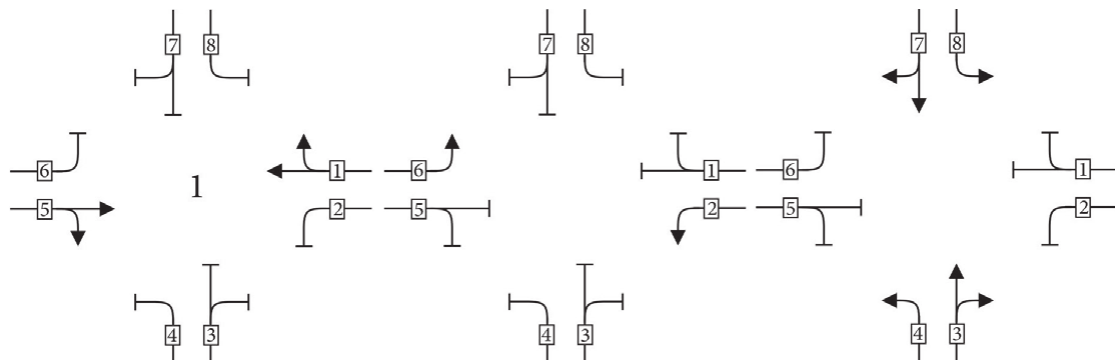
Fig. 9. Signal control